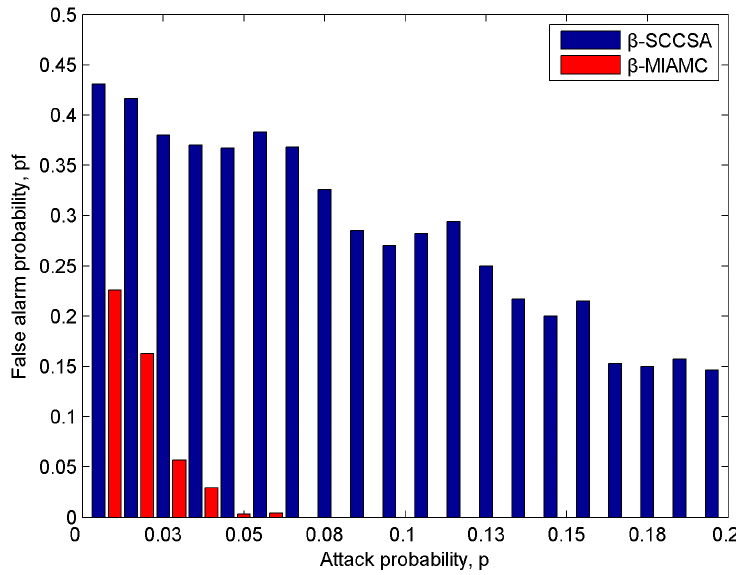
Figure 7. The false alarm probability under different attack probabilities.